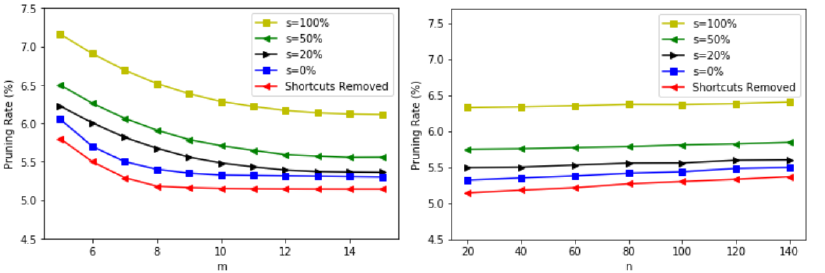
Figure 8. The pruning rate in the deterministic case where L = 1.5, p = 50%. For the left plot n = 20, for the right plot m =